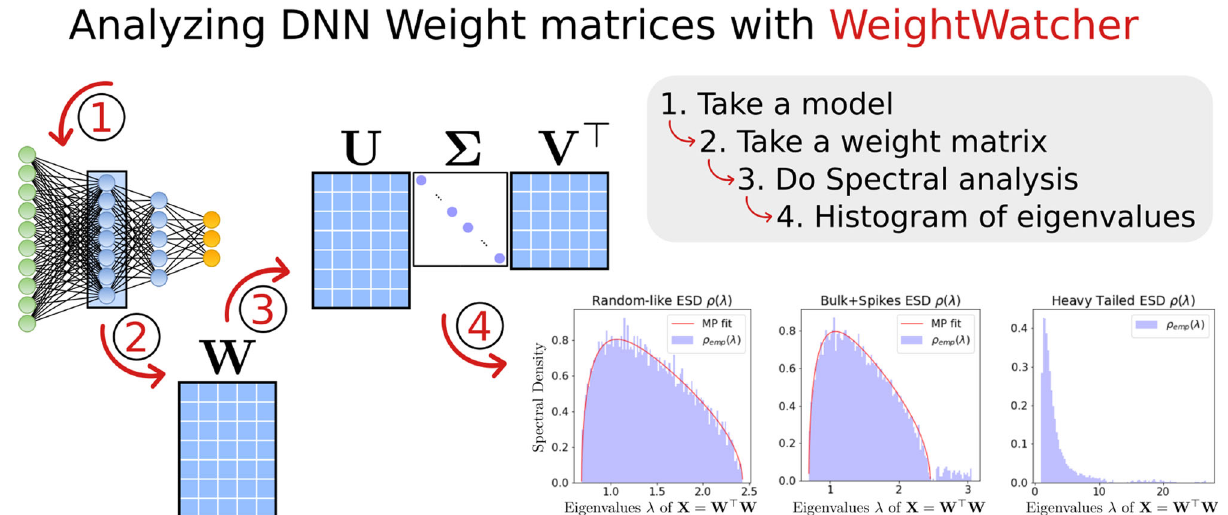
Fig. 1 Schematic of analyzing DNN layer weight matrices W. Given an individual layer weight matrix W , from either a fully connected layer or a convolutional layer, perform a Singular Value Decomposition (SVD) to obtain W = U Σ V T , and examine the histogram of eigenvalues of W T W . Norm-based metrics and PL-based metrics (that depend on fi tting the histogram of eigenvalues to a truncated PL) can be used to compare models. For example, one can analyze one layer of a pre-trained model, compare multiple layers of a pre-trained model, make comparisons across model architectures, monitor neural network properties during training,